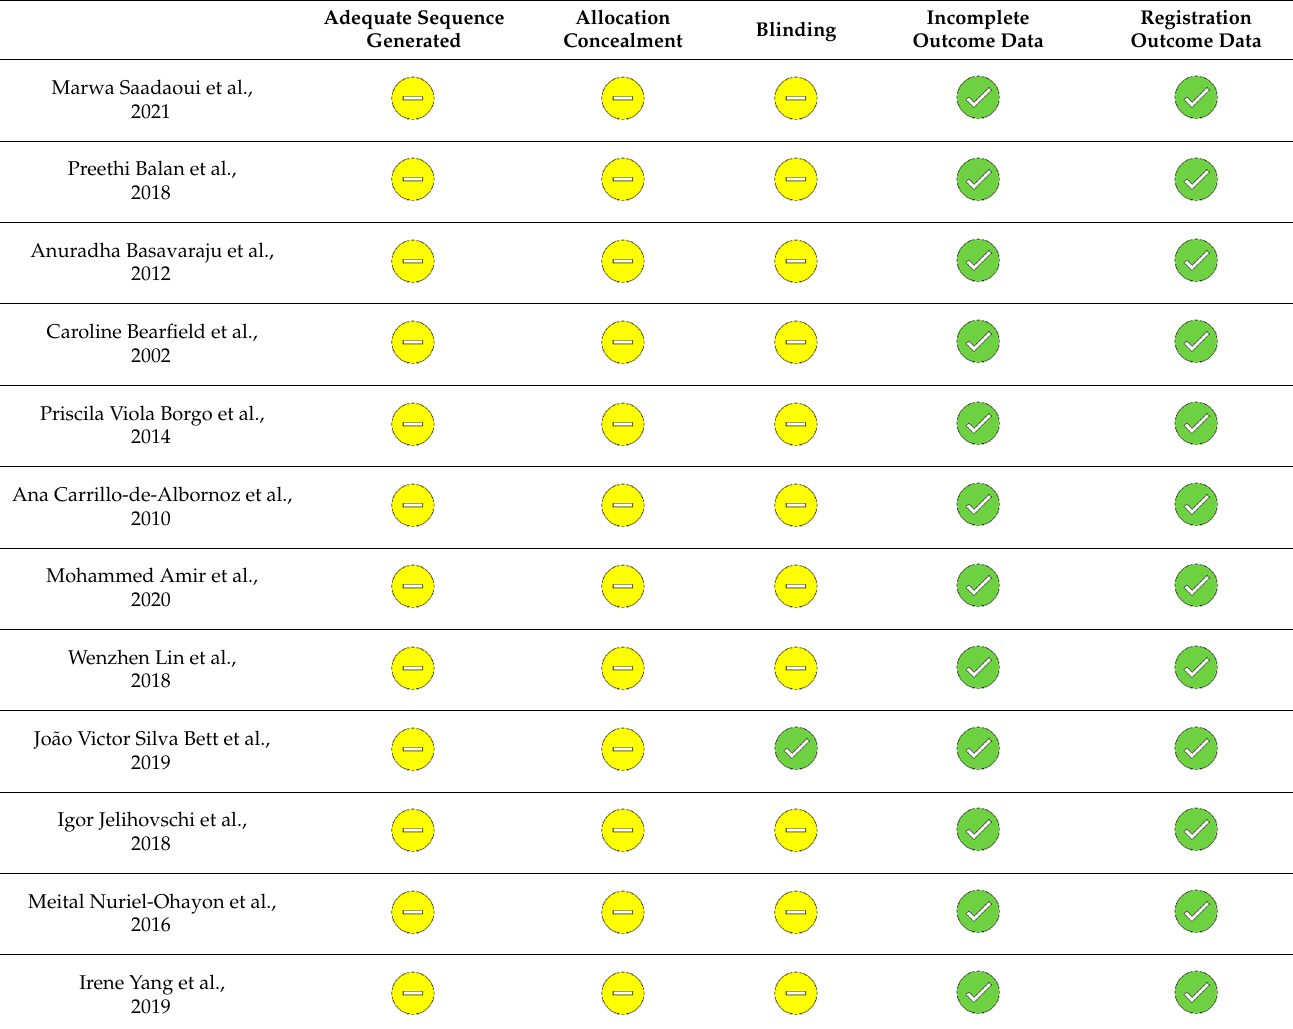
The green symbol means a low risk of bias, the yellow symbol means a moderate risk of bias and the red symbol means an elevated risk of bias. Reported the table in word.